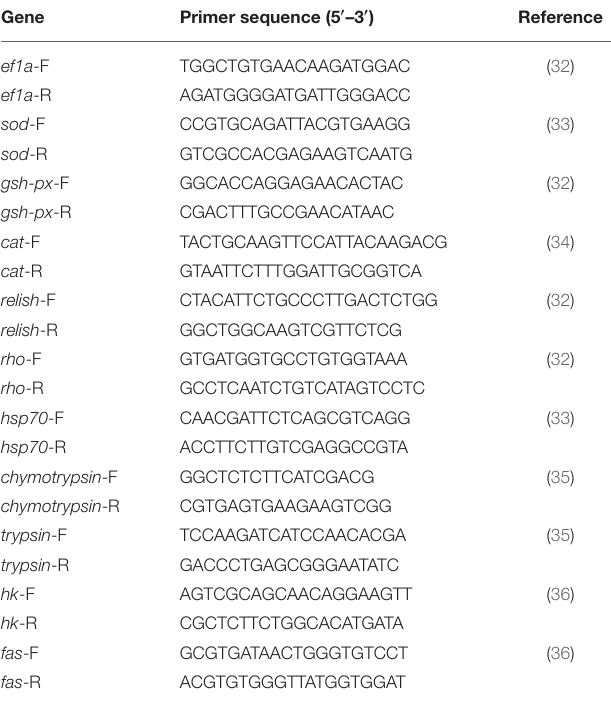
TABLE 3 | Sequences of primers used for real-time quantitative PCR.